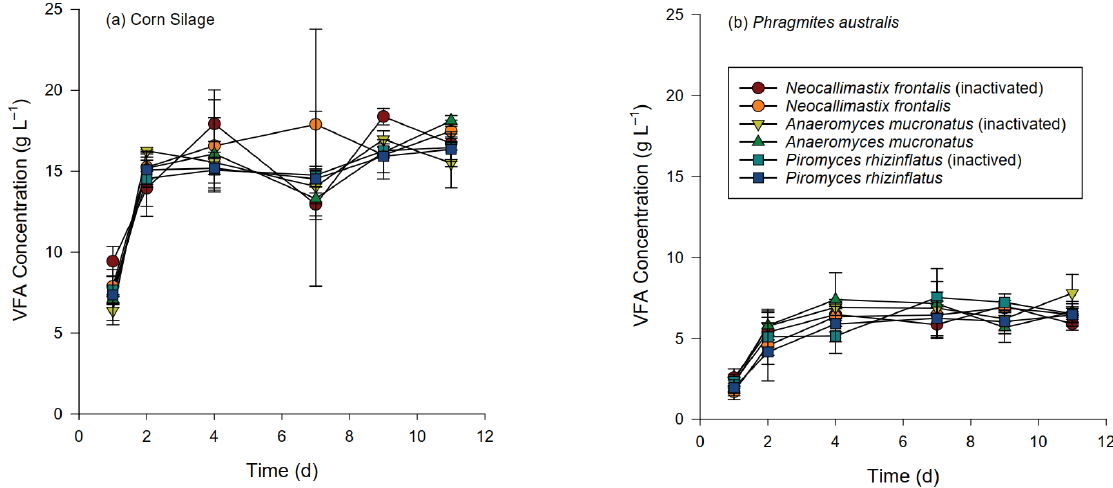
Figure 4. Volatile fatty acids (VFA) production in the bioaugmentation of three different anaerobic fungal species with and without activation: ( a ) corn silage ( Zea mays L.); ( b ) common reed ( Phragmites australis ). Error bars show standard deviation.